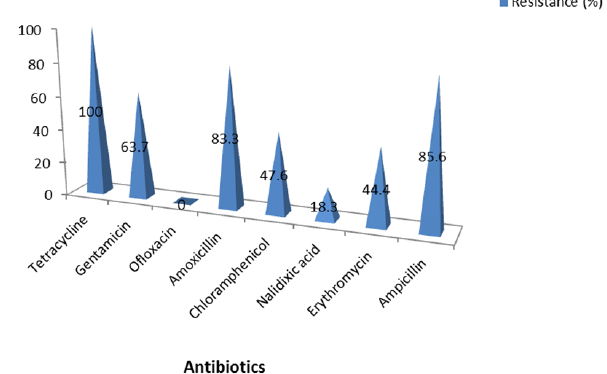
Fig. 7. Antibiogram of Staphylococcus aureus isolated from cow dung used to fertilize fish ponds in New Bussa Nigeria